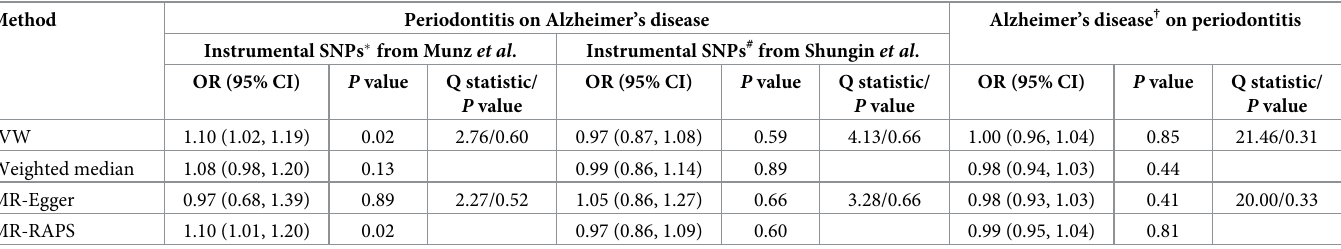
Table 1. Bidirectional MR estimates for the association between chronic periodontitis and Alzheimer’s disease.